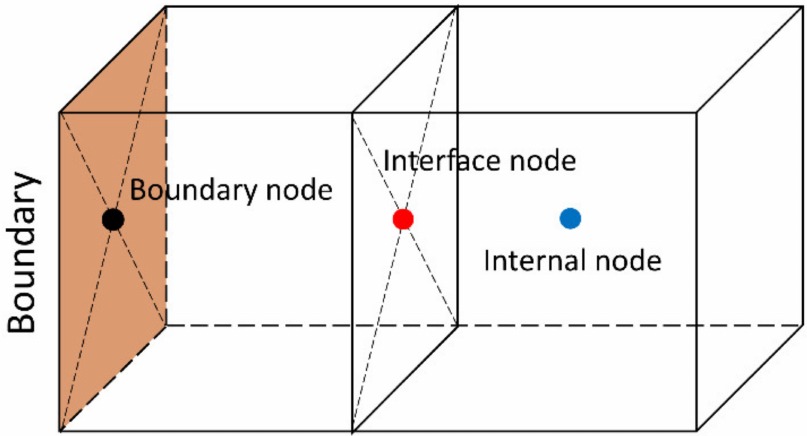
Figure 2. Three kinds of nodes of isoparametric